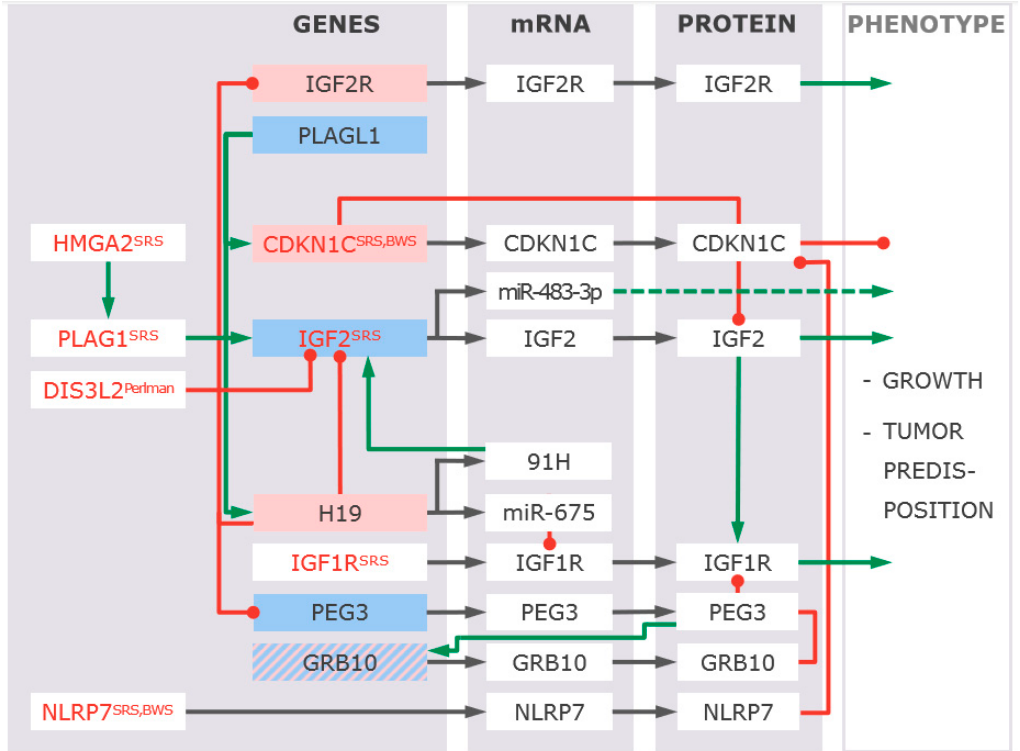
Figure 3. Interactions between genes pathogenic variants in which have been reported in SRS, BWS or related phenotypes (red letters, associated disorders are indicated). Functional interactions can be observed on expression as well as on physiological levels. Genes depicted in blue boxes are expressed from the paternal allele, whereas in red boxes maternally expressed genes are shown. Promoting interactions are indicated by green lines/arrows, red lines indicate inhibition. The effect of pathogenic variants in these genes/factors, such as over/underexpression, is not shown. Table 1. Molecular findings in patients with Beckwith–Wiedemann syndrome (BWS) or Silver–Russell syndrome (SRS)